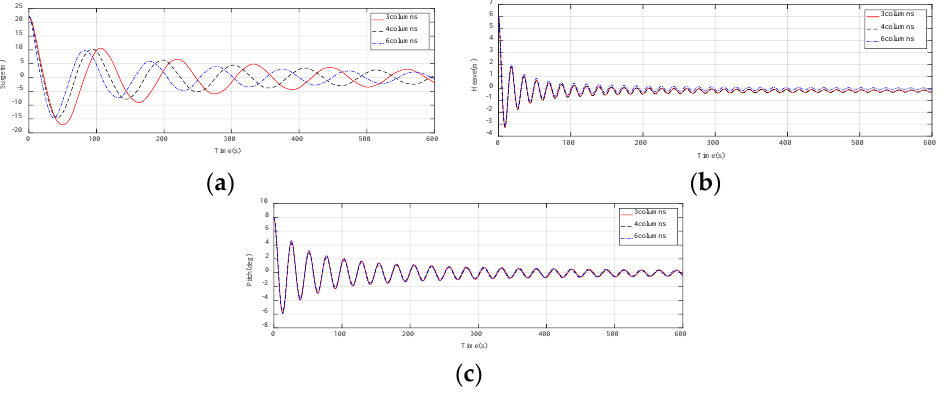
Figure 8. Floating offshore wind turbines (FOWT) platform motions in the free-decay test. ( a ) LCI; ( b ) LCII; and ( c )